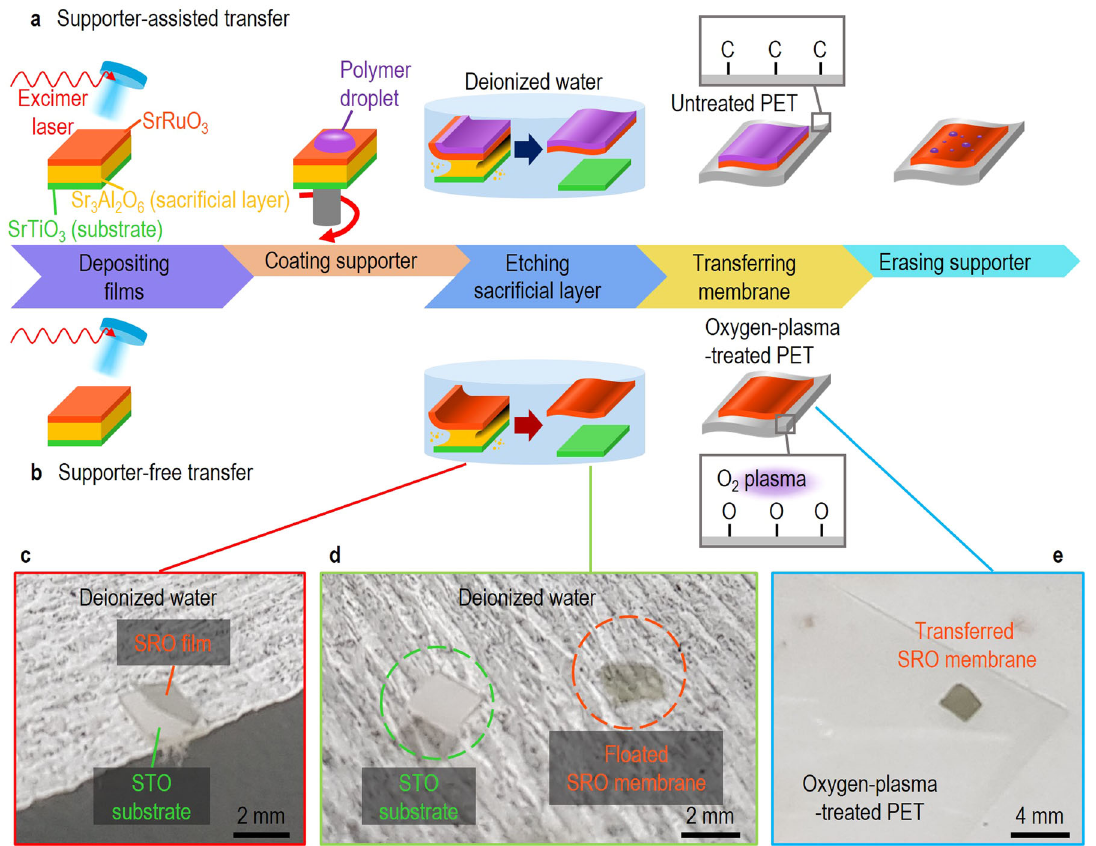
Fig. 1 Process to transfer ultrathin, clean, and wide single-crystalline (SC) SrRuO 3 (SRO) membranes onto fl exible polyethylene terephthalate (PET) substrates. a Conventional support-assisted transfer process includes coating an organic support material for easy handling; however, it is a fi ve-step process and tends to leave a dirty residue on the surface. Without the support material, the SC SRO membranes easily crumple, roll, and tear, so it is dif fi cult to transfer membranes that are thinner than those with a sub-hundred-nanometre thickness. b Using the proposed support-free transfer process, we transferred SC SRO membranes as thin as 15 nm onto an oxygen-plasma- treated PET substrate. Given that organic supports are not required for our method, the entire process involves only three steps. The photographs show the c selective etching of the sacri fi cial layer in deionized water, d fl oated SC SRO membranes in deionized water, and e transferred SC SRO membrane onto the oxygen-plasma-treated